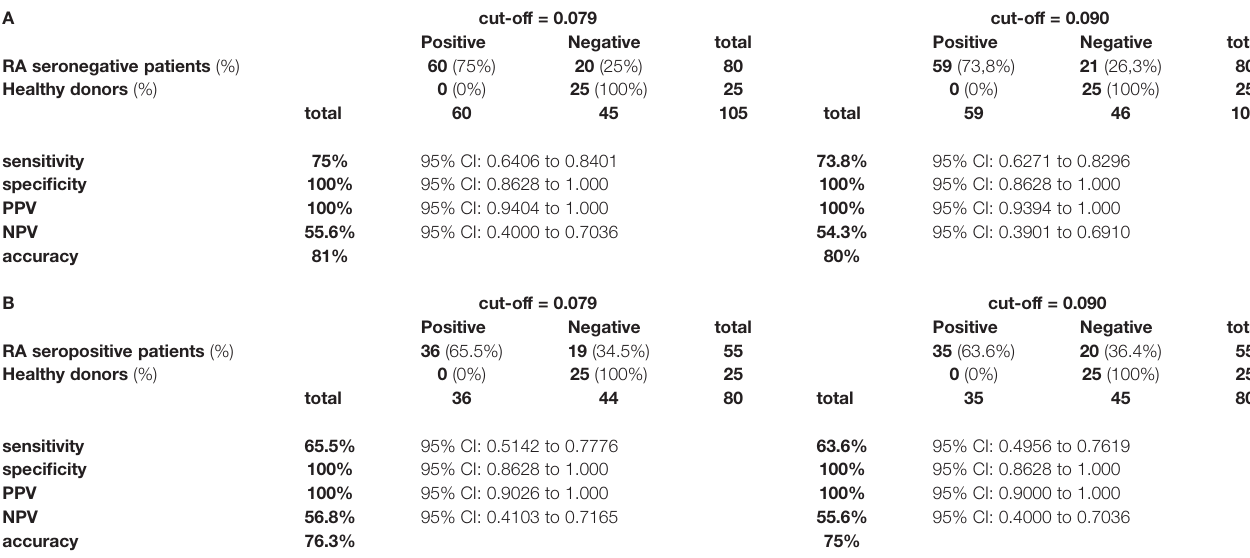
TABLE 2 | Association of high level of anti-RA peptide Abs with diagnosis of RA. A cut-off = 0.079